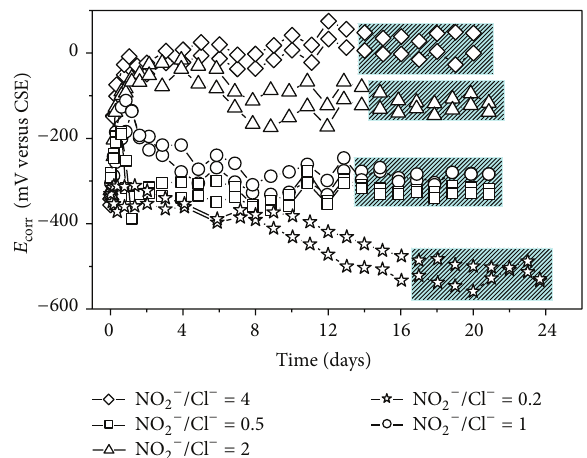
Figure 1:Timeevolution curves of 𝐸 0.2 mol/L NO 2− and with different mole ratio of NO 2− /Cl −